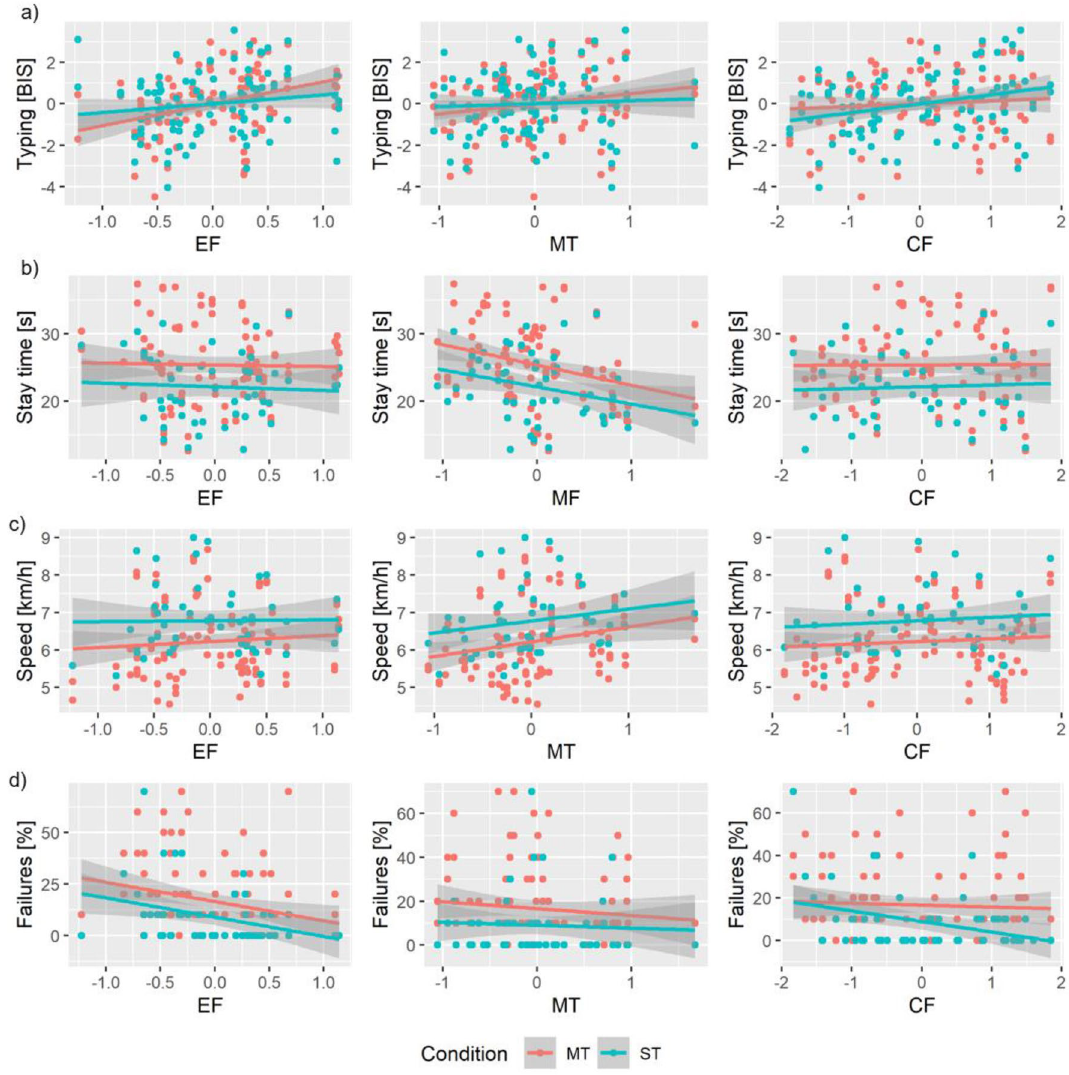
Figure 1. Linear mixed-effects model results showing effects of executive functions, motor coordinative fitness, and cardiovascular fitness on the outcome variables ( a ) typing, ( b ) crossing failures, ( c ) stay time, and ( d ) crossing speed, separately for single- and multitask condition. Model-predicted means and 95% CI are shown. EF = executive functions, MF = motor coordinative fitness, CF = cardiovascular fitness, ST = single-task condition, MT = multitask